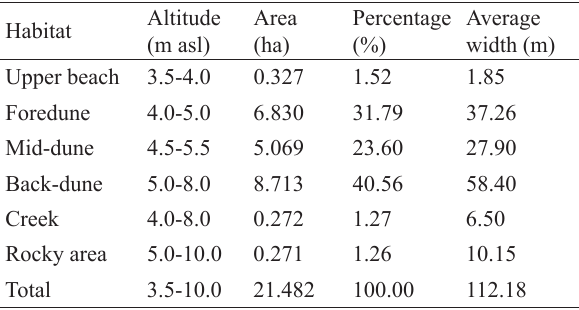
Table 4. Characteristics of the